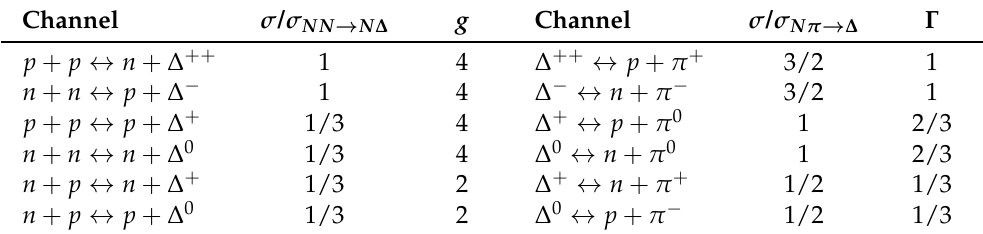
Table 2. Isospin-dependent channels for ∆ resonances and pion productions with the corresponding cross sections ( σ ), spin-isospin factors ( g ), and the decay widths ( Γ ).